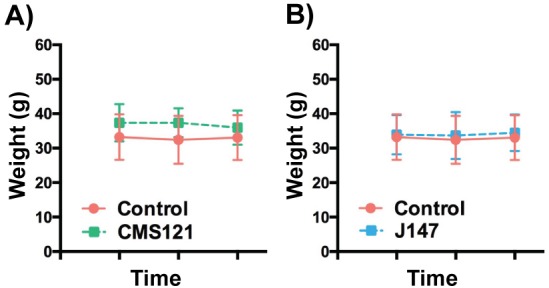
Body weights of SAMP8 mice fed with vehicle, CMS121 and J147 diets.9 months old female SAMP8 mice were fed with vehicle (n = 23), CMS121 (n = 22) or J147 (n = 22) diets until 13 months. Six SAMP8 mice fed with control diet, four SAMP8 mice fed with CMS121 diet and four SAMP8 mice fed with J147 diet died throughout the course of this study. No significant differences were found between the body weights of the two groups at three different time points (9 months, 11 months and 13 months). Two-way repeated measures ANOVA and post hoc Bonferroni corrected t-test. All data are mean ± SD.